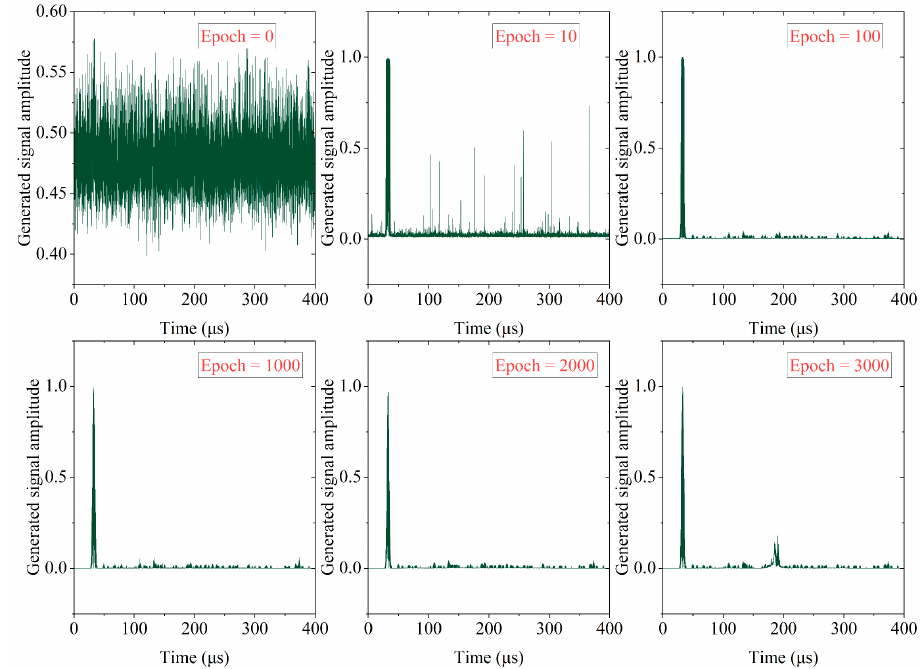
Figure 4. US-WGAN generated signals for different training